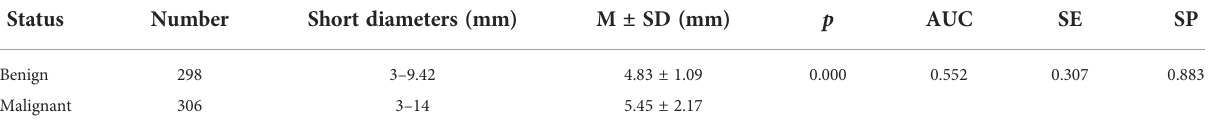
TABLE 3 Comparison of malignant and benign